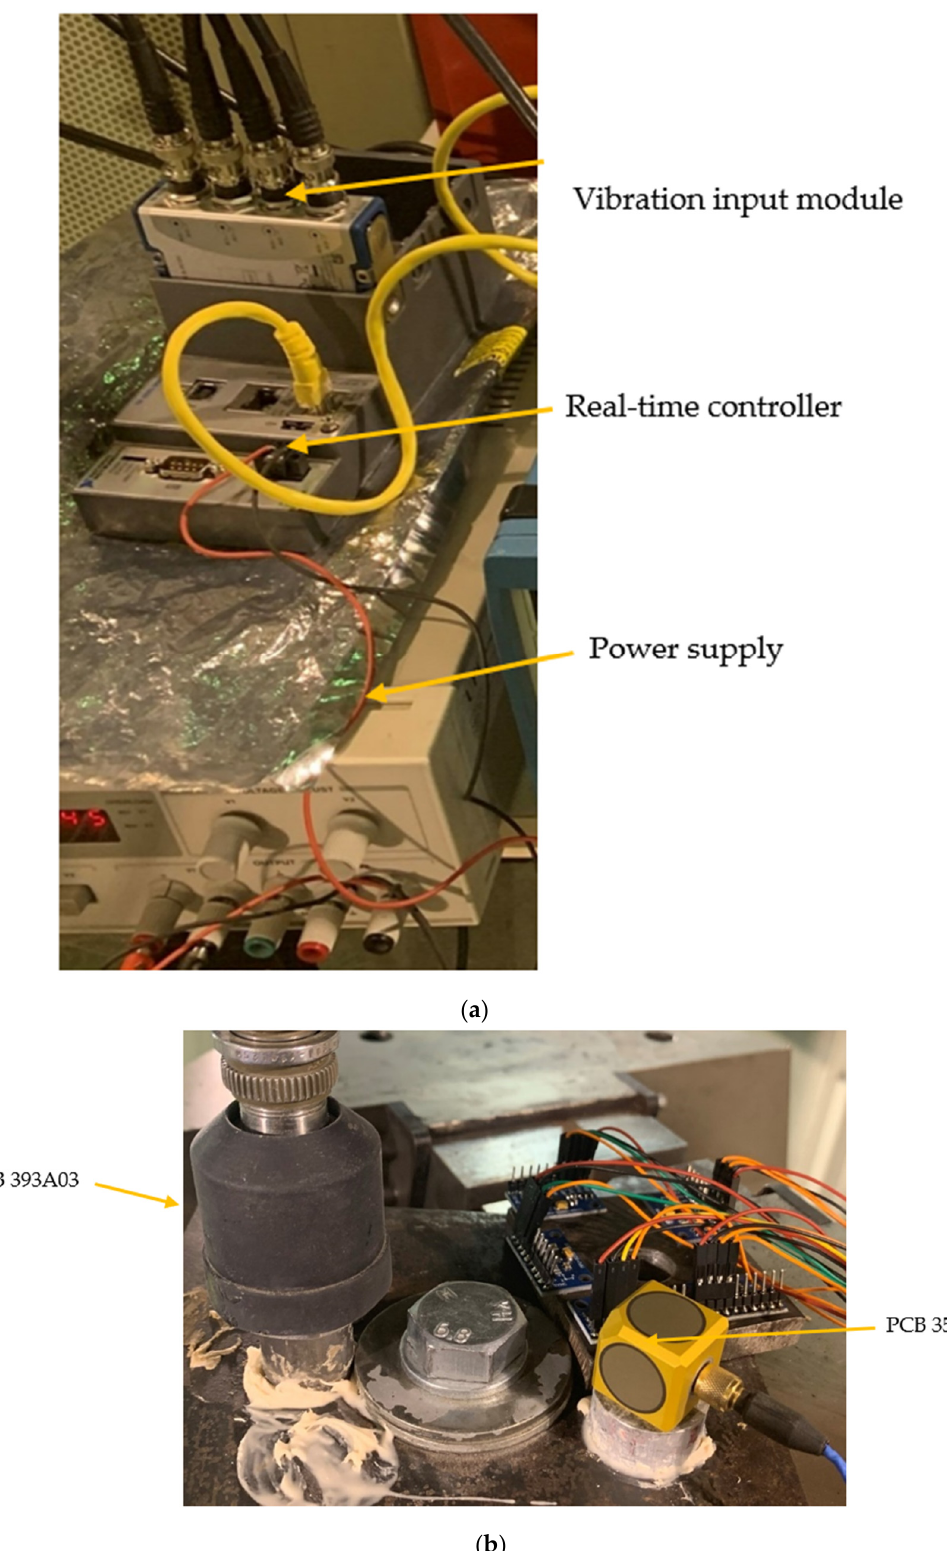
Figure 1. Control systems: ( a ) Data acquisition system for piezoelectric accelerometers and ( b ) Positioning of the